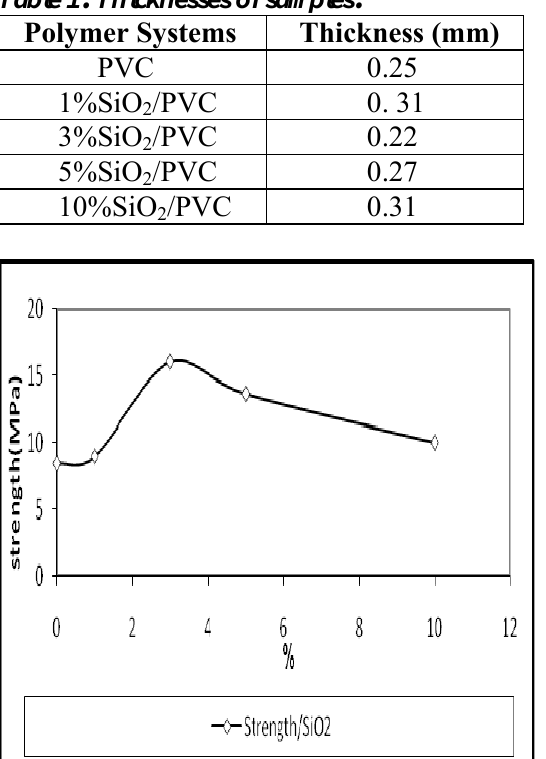
Fig. 1: Change in strength versus weight ratios. Characterization of